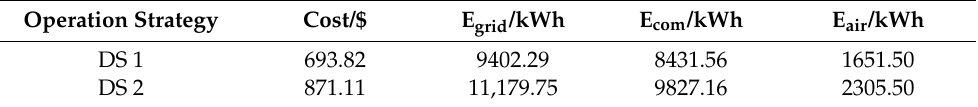
Table 2. Comparison of the simulation results of DS 1 and DS